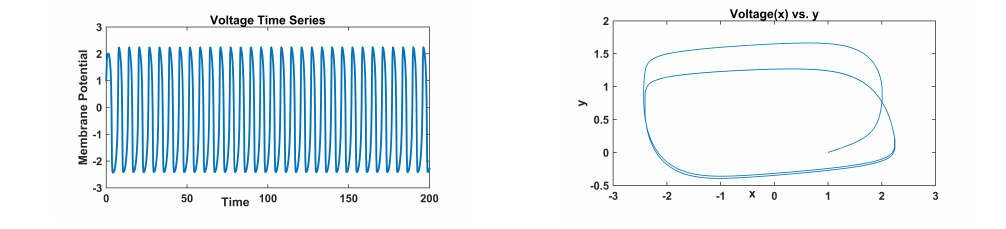
Figure 24. Recovery variable (right) with a constant external current value, I(t) = 2 sint µ A / cm 2 , a = 0.8 , b = 0.7 & c = 3